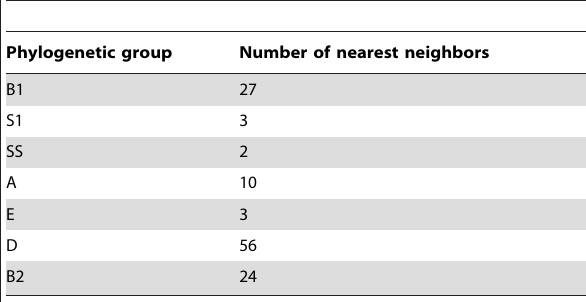
Table 1. Distribution of the nearest neighbors of the 125 putative recombinant genes in the ON2010